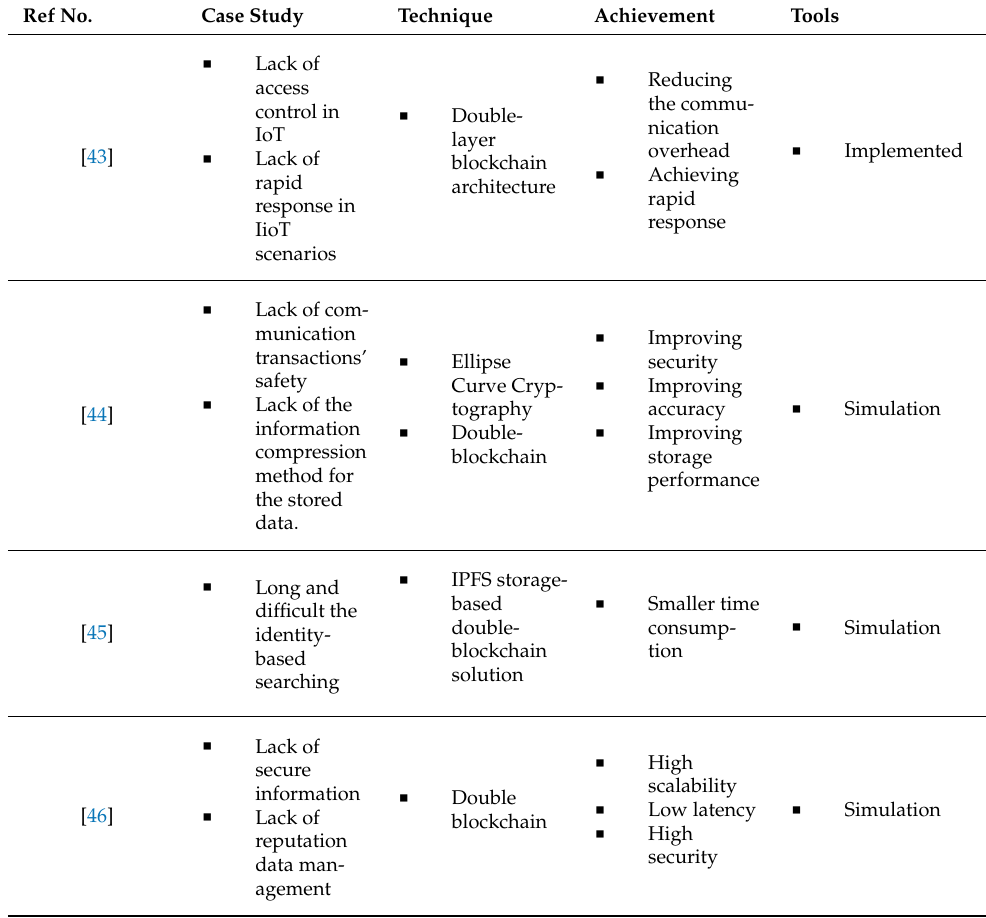
Table 4. A summary of double-blockchain architecture case studies. Table 2. Inclusion and exclusion criteria.